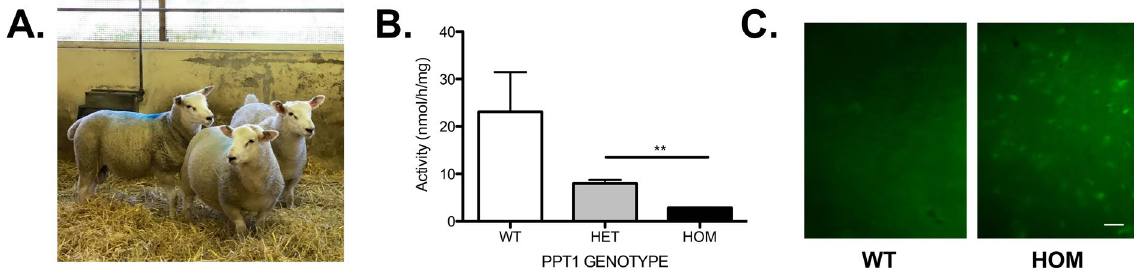
Figure 2. Confirmation of CLN1 disease. ( A) Asymptomatic homozygote PPT1 sheep. ( B ) PPT1 enzyme activity assay tested in plasma (20ug protein) detected significant differences between heterozygote and homozygote sheep (P = 0.0025). Statistical analyses utilized unpaired two-tailed Student’s t-test. Error bars represent the standard error of the mean (SEM). ( C ) Autofluoroscent inclusion bodies are detected in homozygote sheep scale bar represents 50